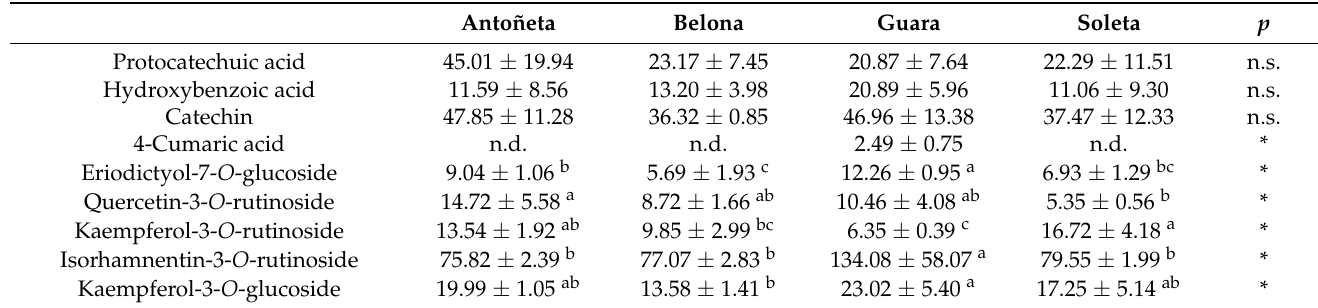
Table 2. Identification and content of phenolic compounds ( µ g/g of sample) in the aqueous extract of Antoñeta, Belona, Guara and Soleta almonds by HPLC-DAD. Values are reported as mean ± SD (n =